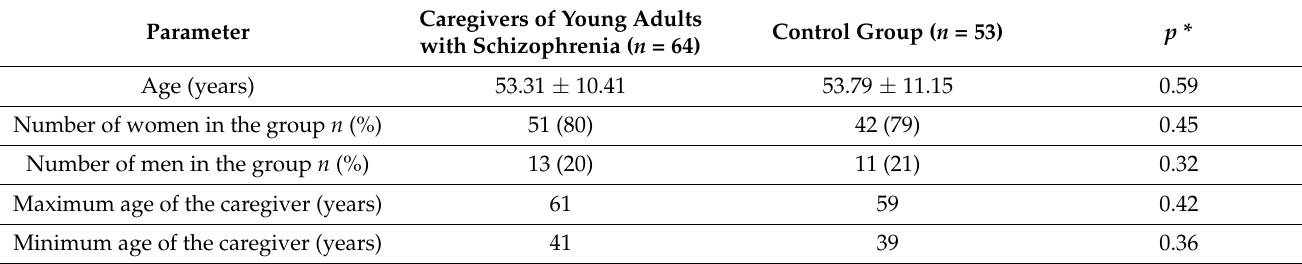
Table 1. Demographic data of caregivers of young adults with schizophrenia and control group.